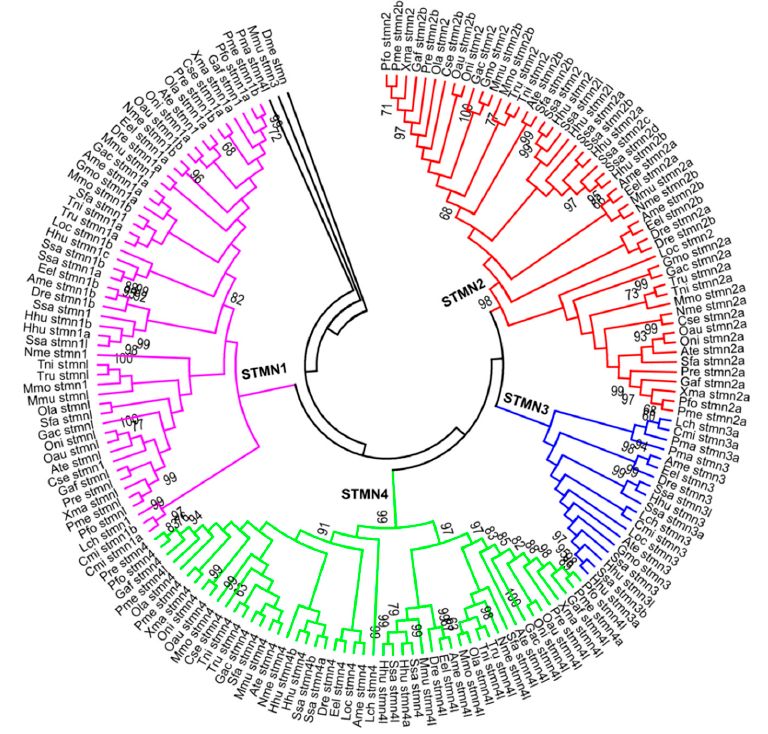
Figure 1. Phylogenetic relationships of the stathmin genes in 27 species of fish. A neighbor-joining (NJ) phylogenetic tree was constructed and four groups (STMN1, STMN2, STMN3, and STMN4) were classified based on the phylogeny and sequence similarity. Dme_stmn gene (FBgn0266521) of a fruit fly was used as an outgroup.